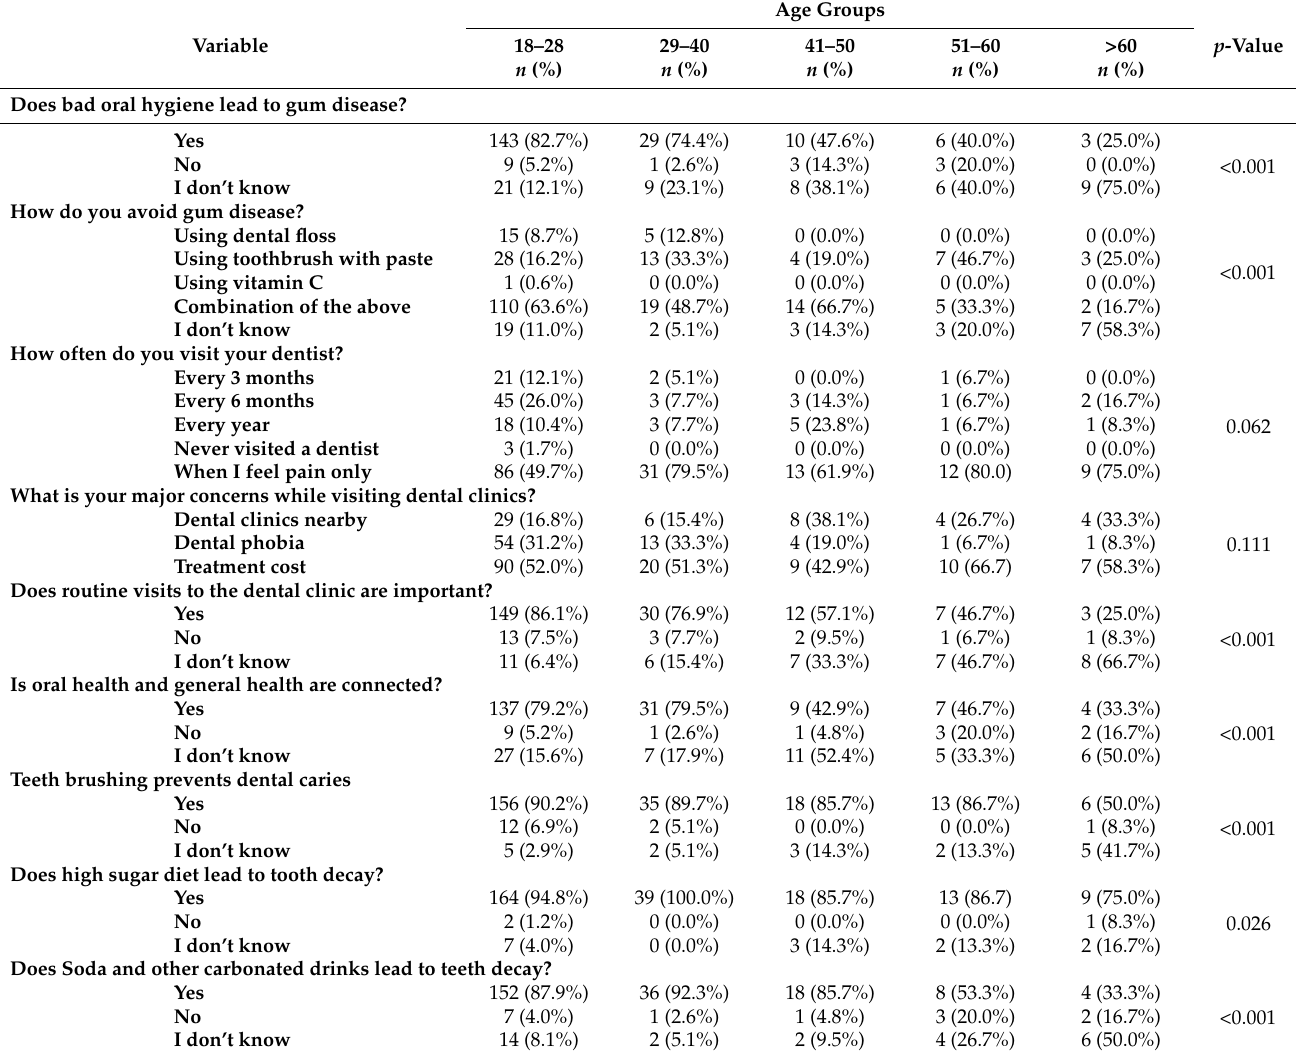
Table 3. Association of knowledge, attitude and practices towards oral health maintenance with respect to age